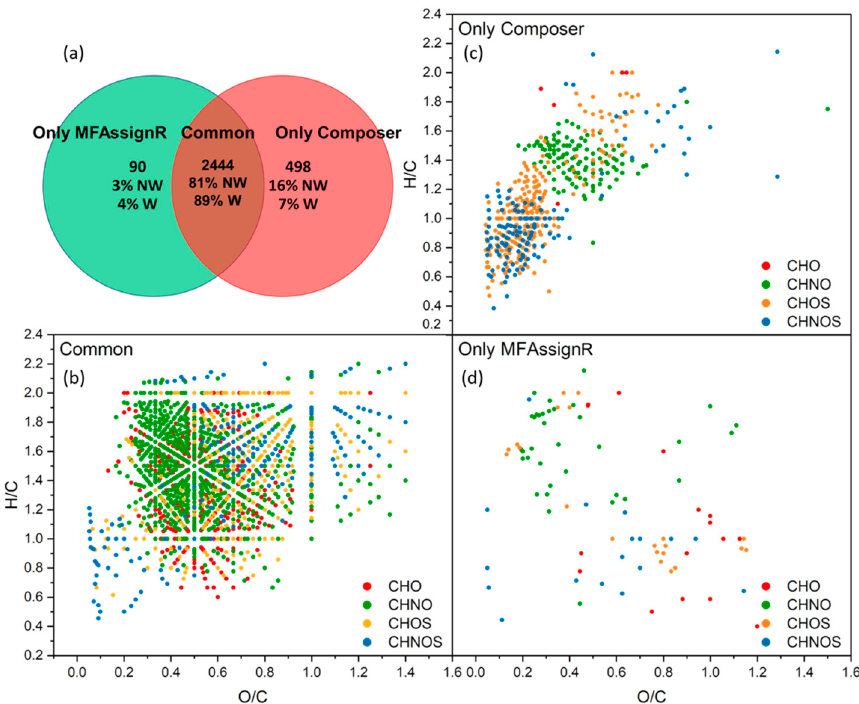
Figure 10. ( a ) Venn diagram comparing the number of MFs, the non-weighted (NW) and the weighted (W) percentages assigned by data treatment with Composer (red) and MFAssignR (green); ( b ) van Krevelen diagram of compounds belonging to “Common”: in red are compounds containing carbon, hydrogen, and oxygen (CHO), in green are compounds containing carbon, hydrogen, nitrogen, and oxygen (CHNO), in yellow are compounds containing carbon, hydrogen, oxygen, and sulfur (CHOS), and in blue are compounds containing carbon, hydrogen, nitrogen, oxygen, and sulfur (CHNOS); ( c ) van Krevelen diagram of compounds belonging to “Only Composer”; ( d ) van Krevelen diagram of compounds belonging to “Only MFAssignR”.